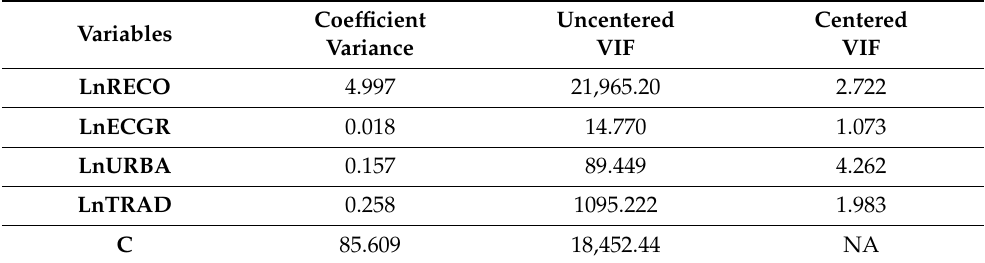
Table 4. Outcomes of variance inflation factor (VIF) (multicollinearity